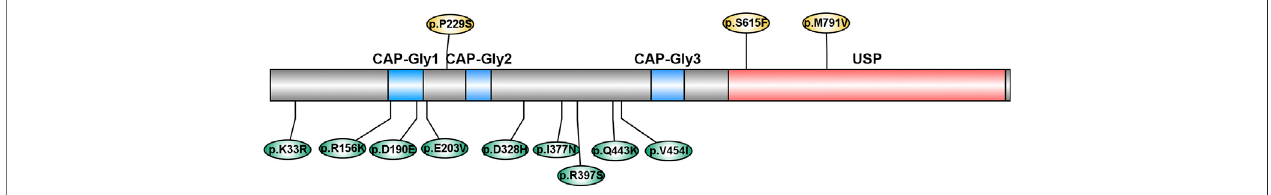
FIGURE 2 | Schematic diagram of variants in CYLD . CAP-Gly: cytoskeleton-associated protein-glycine conserved domain; USP: ubiquitin-speci fi c protease domain. Variants reported by previous studies were labeled above, and variants reported in our study were labeled below.